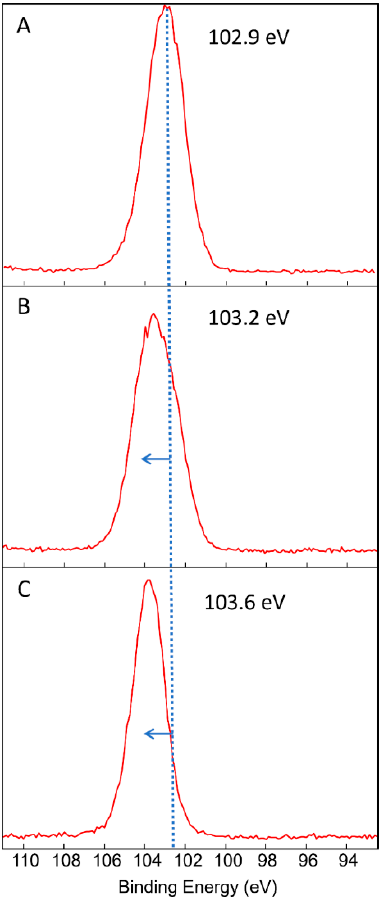
Figure 2. Si2p peak acquired by XPS peak analyses of the PD3m ( A ), PD20m ( B ), and PD3m-P ( C ) coatings. A shift toward a higher binding energy can be seen for the PD20m and PD3m-P samples compared to PD3m .